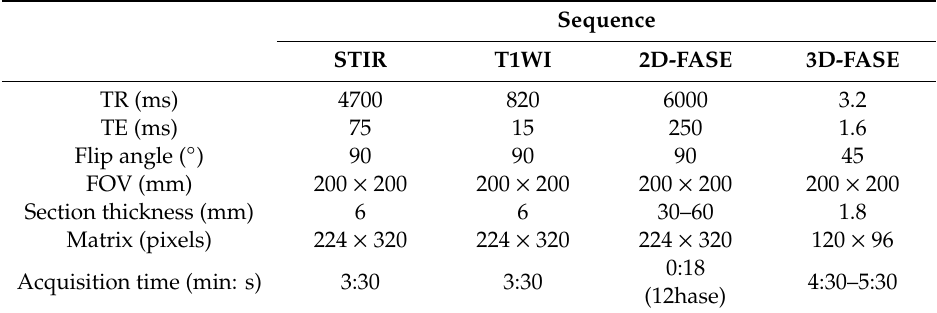
Table 2. Imaging parameters of each